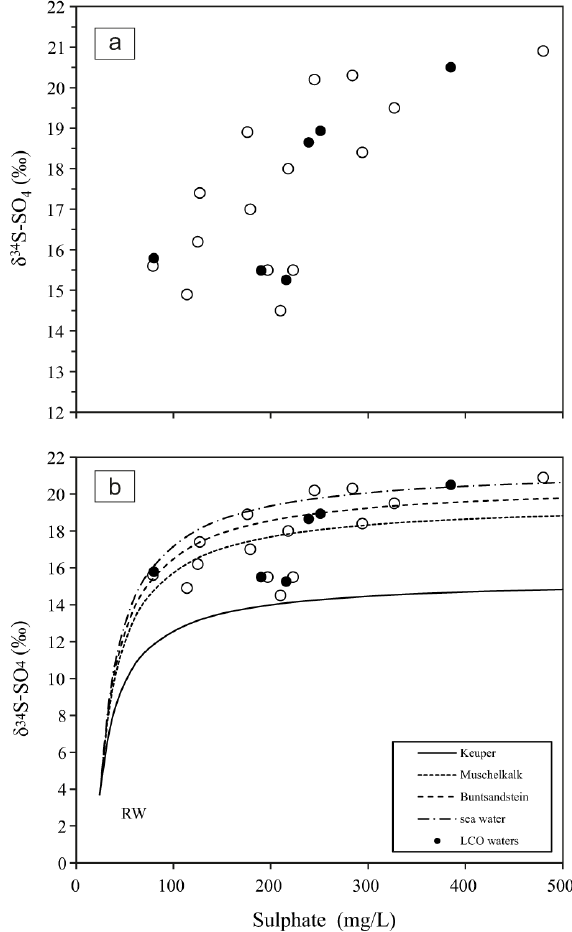
Fig. 8. Plot of δ 34 S-SO 4 and SO 4 concentrations for the investi- gated waters (a) . The mixing lines (solid curve) between rainwater and Triassic evaporites are shown (b) . The displayed isotopic and chemical data of rainwater (RW, δ 34 S=+3.7‰; SO 4 =24mgL − 1 ) refer to September 2011 sampling carried out near the Baratz Lake (see Fig. 1), while the data on Triassic evaporites are from Krouse and Grinenko (1991) and references therein ( δ 34 S=+15.4‰ is the mean value for marine sulfates of Keuper; δ 34 S =+ 19.6‰ is the mean value for marine sulfates of Muschelkalk and δ 34 S = 20.6‰ refers to marine sulfates of Buntsandstein). The δ 34 S value of sea- water is 21.6‰. The symbols are as in Fig.